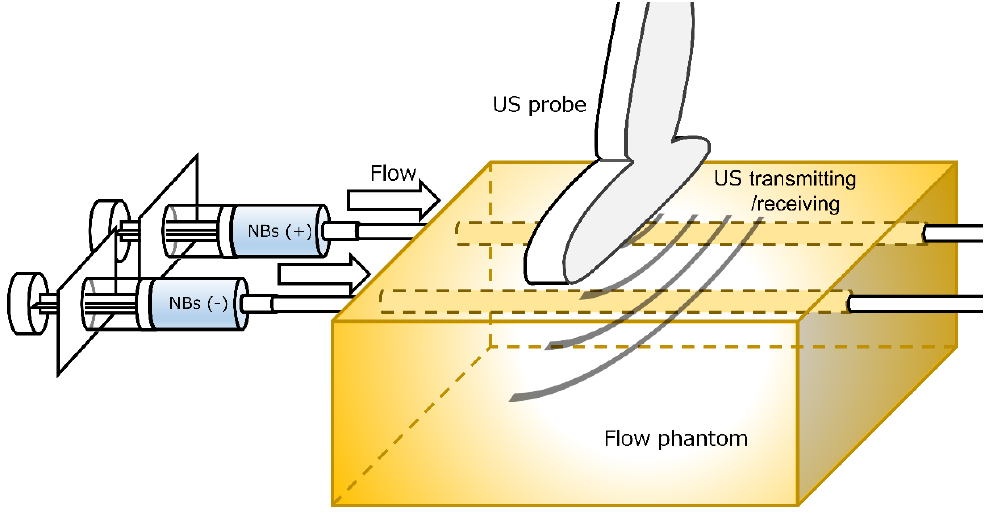
Figure 2. Flow phantom and measurement set up to characterize regenerated NBs with ultrasound. NBs (+): solution with nanobubbles; NB (−): solution without nanobubbles.